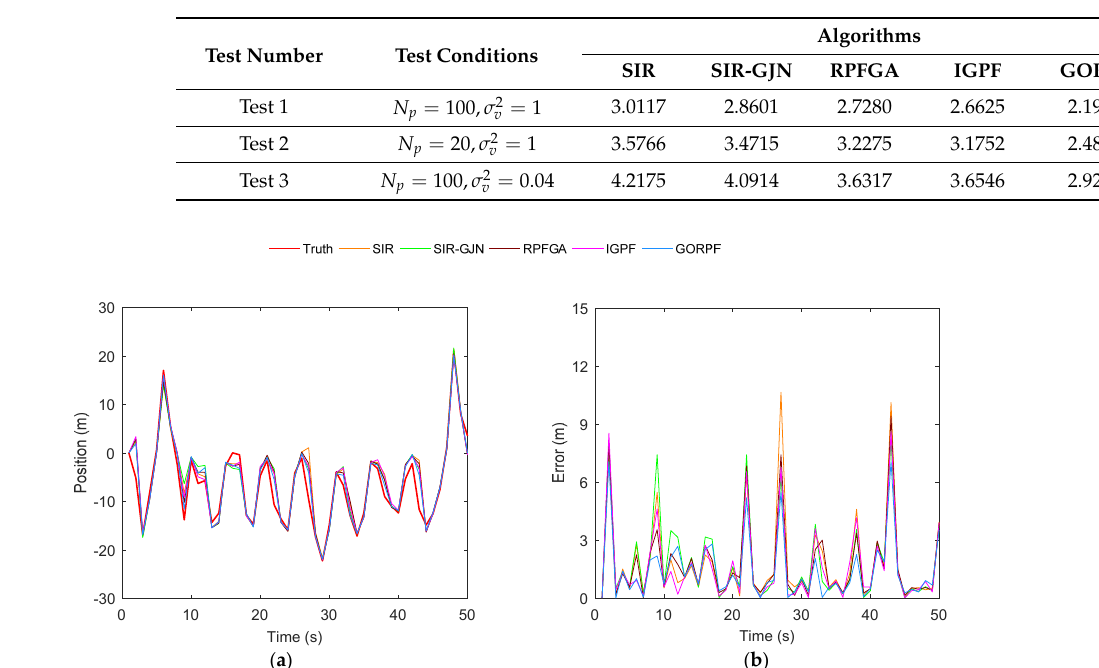
Figure 4. Target tracking performance of the five particle filter-based algorithms (with 100 particles) under normal measurement noise condition ( σ 2 v = 1). ( a ) Tracking trajectories; ( b ) Absolute errors at each time step.